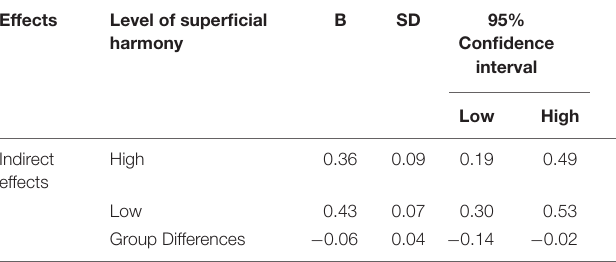
TABLE 4 | Indirect effects test of different conditions.